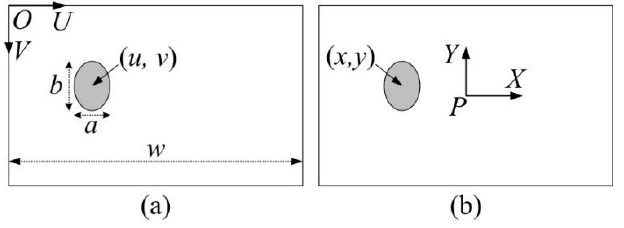
Figure 4. Diagram showing the disc-like label in the coordinate frames: ( a ) the pixel coordinate frame U-O-V ; ( b ) the image plane coordinate frame X-P-Y